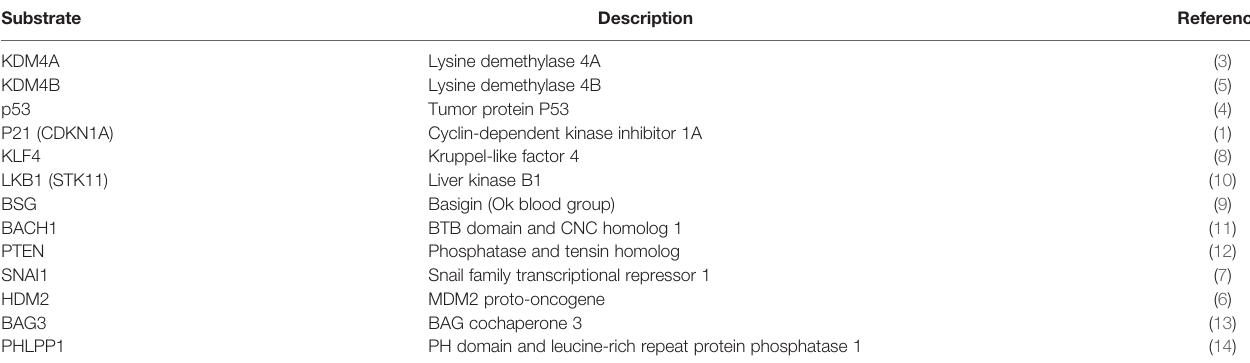
TABLE 1 | Target substrates for FBXO22